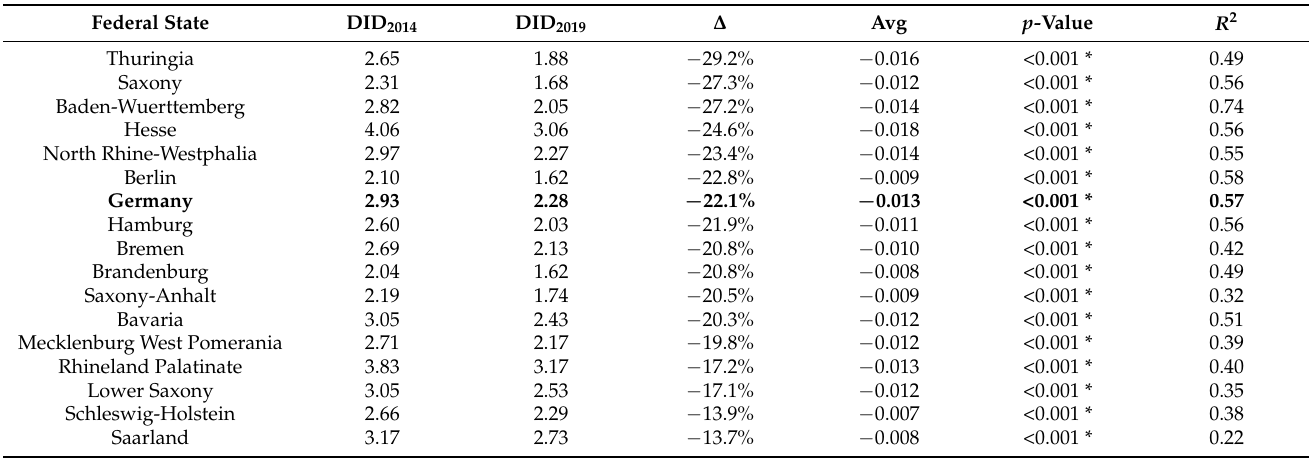
Table 3. Trends for monthly cephalosporin DID during 2014–2019. Abbreviations: DID 2014 , Average DID in 2014; DID 2019 , Average DID in 2019; ∆ , percentage difference between 2019 and 2014 values; Avg, average monthly change in DID. In order to account for the different alpha levels for the individual federal states due to the Bonferroni-Holm method, Avg that are significantly different from zero are marked with *; R 2 , coefficient of determination for the applied model.